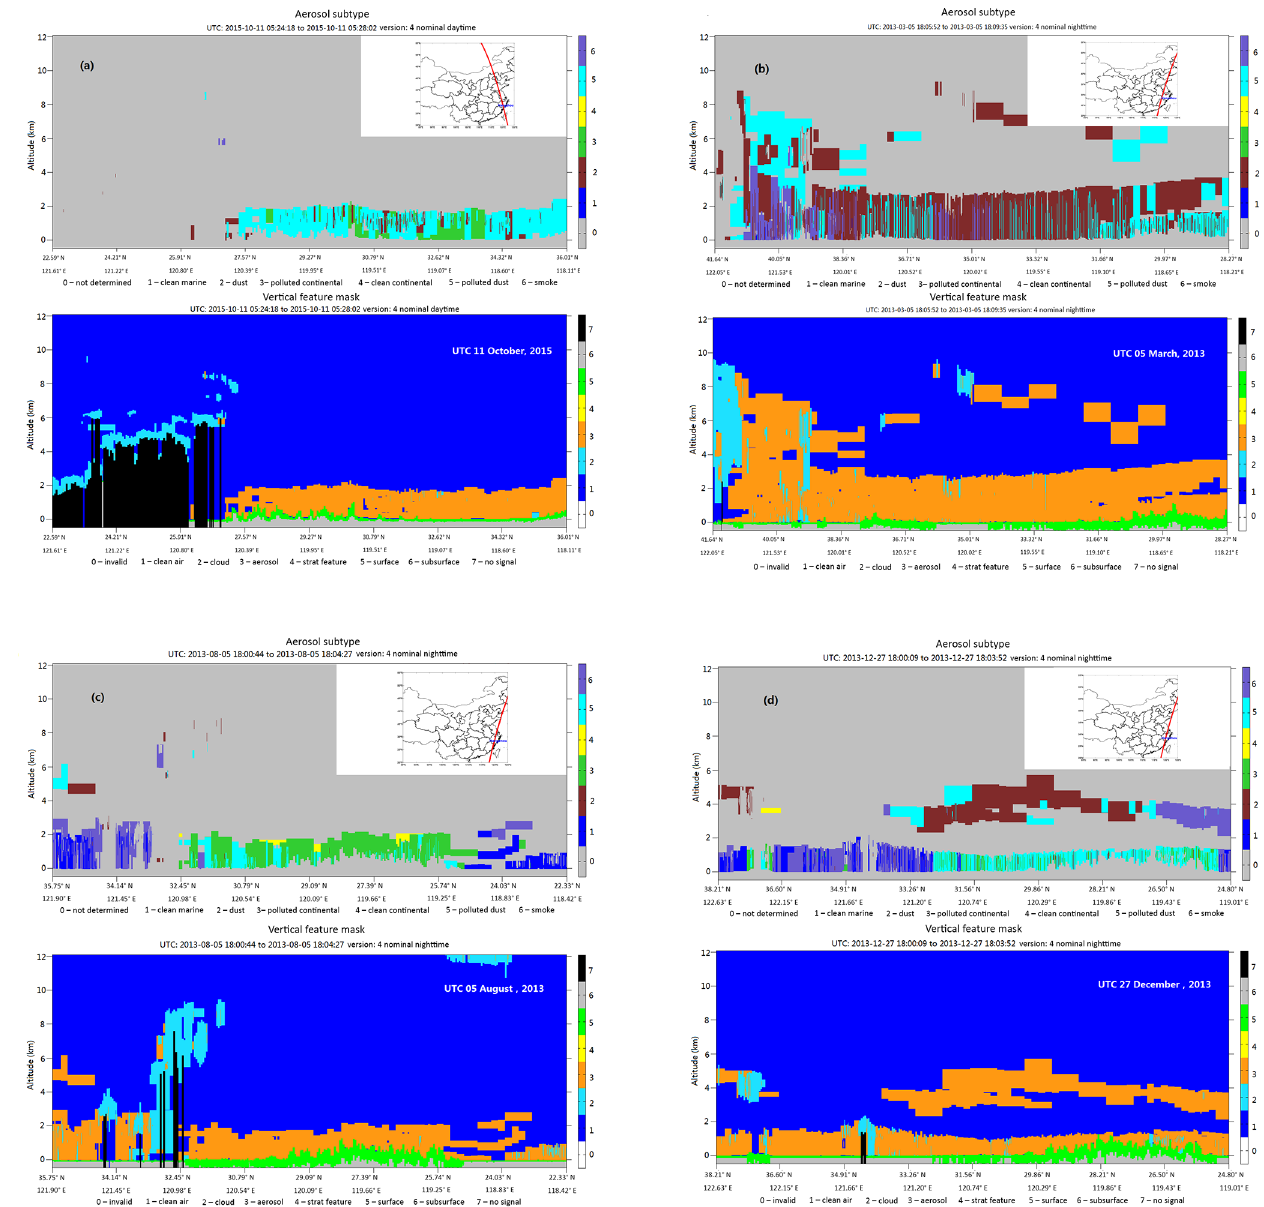
Figure 8. CALIPSO L2 products of vertical feature mask, aerosol subtype, and its ground track on (a) 11 October 2015, (b) 5 March 2013, (c) 5 August 2013, and (d) 27 December